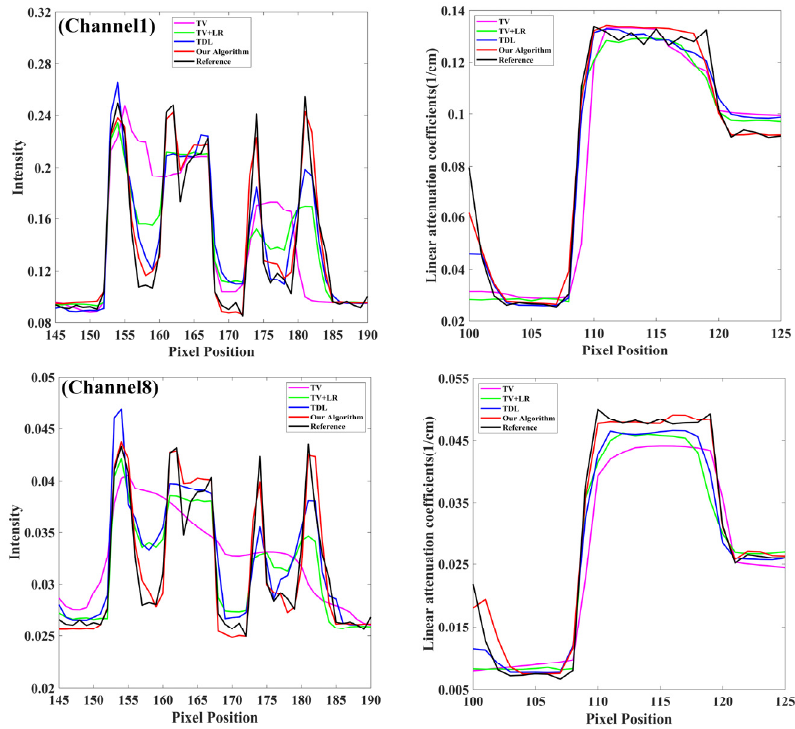
Figure 4. Comparison of the profile from 80 views. The comparison algorithm is displayed in the legend.